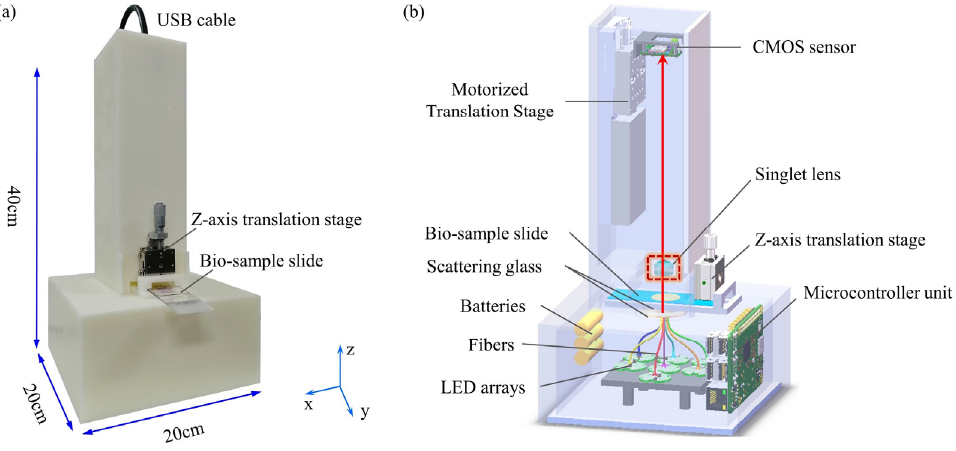
Figure 16. Singlet multi-spectral microscopy [107]: ( a ) photograph, and ( b ) a 3D mechanical de- sign.